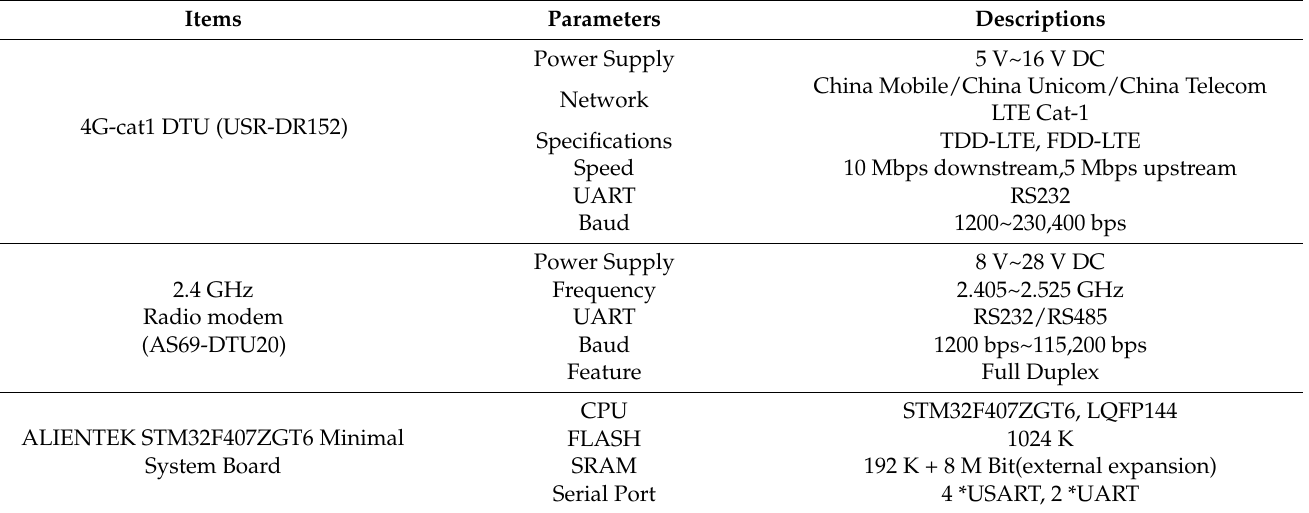
Table 2. Main parameters of DTU and Core board.